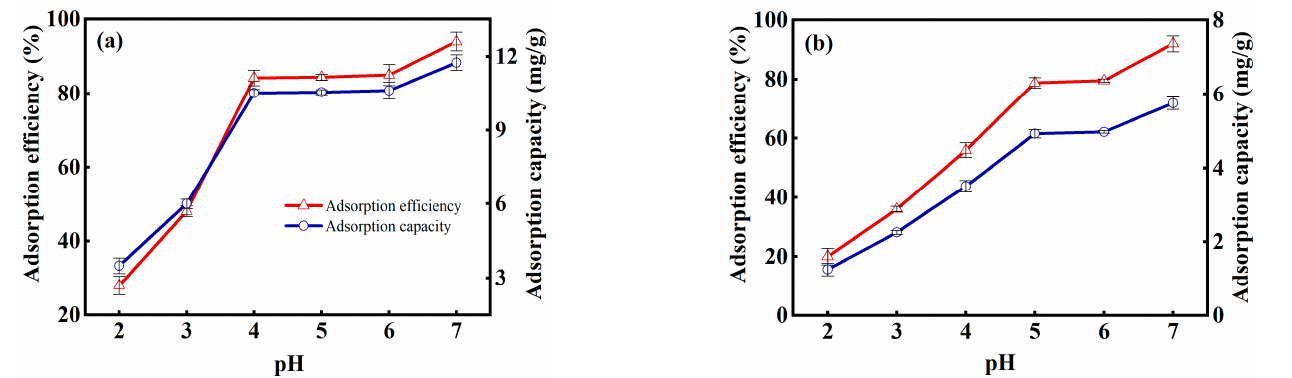
Figure 5. Effect of pH value on adsorption efficiency: ( a ) Pb ion; ( b ) Cd ion.